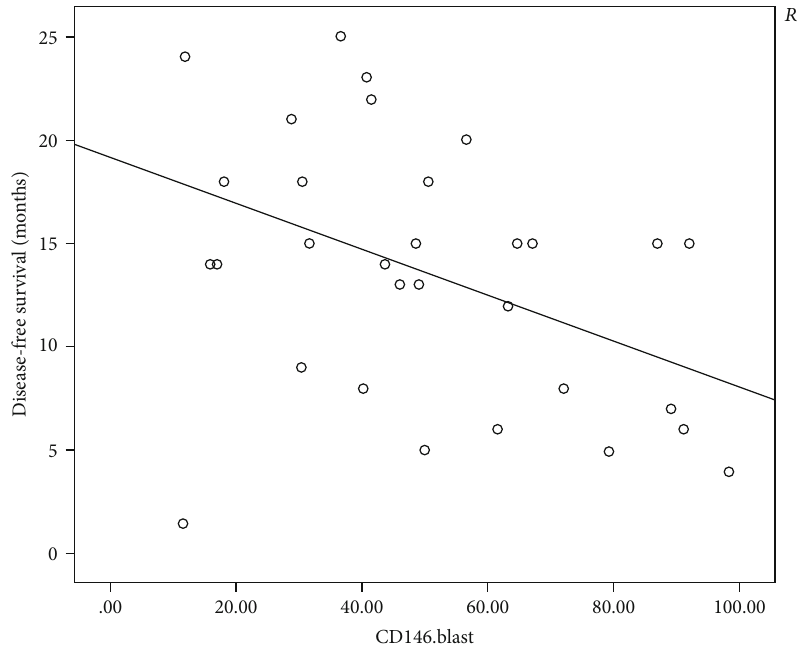
Figure 8: Scatter plot of the relation between CD146 + blasts and